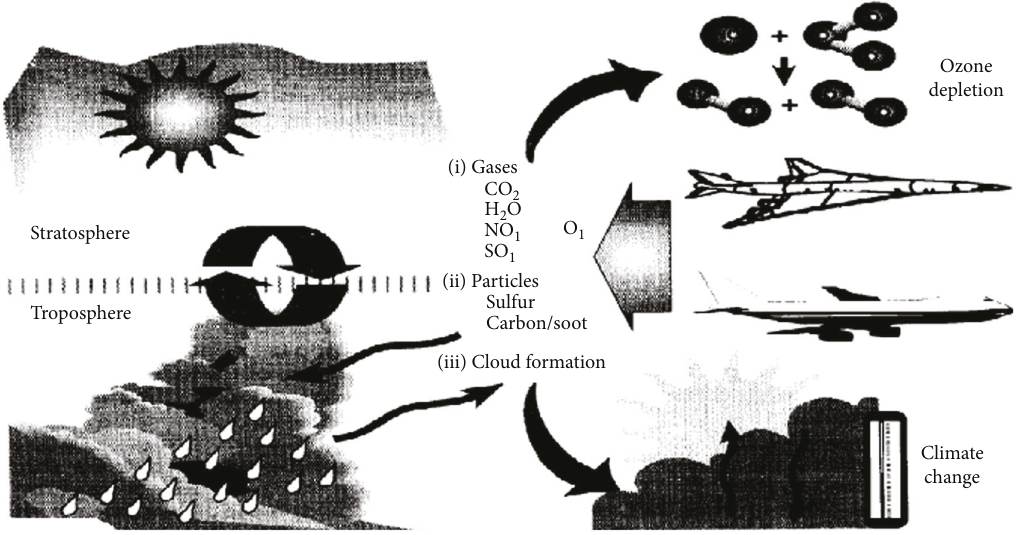
Figure 1: Aircraft emissions and the global environment.